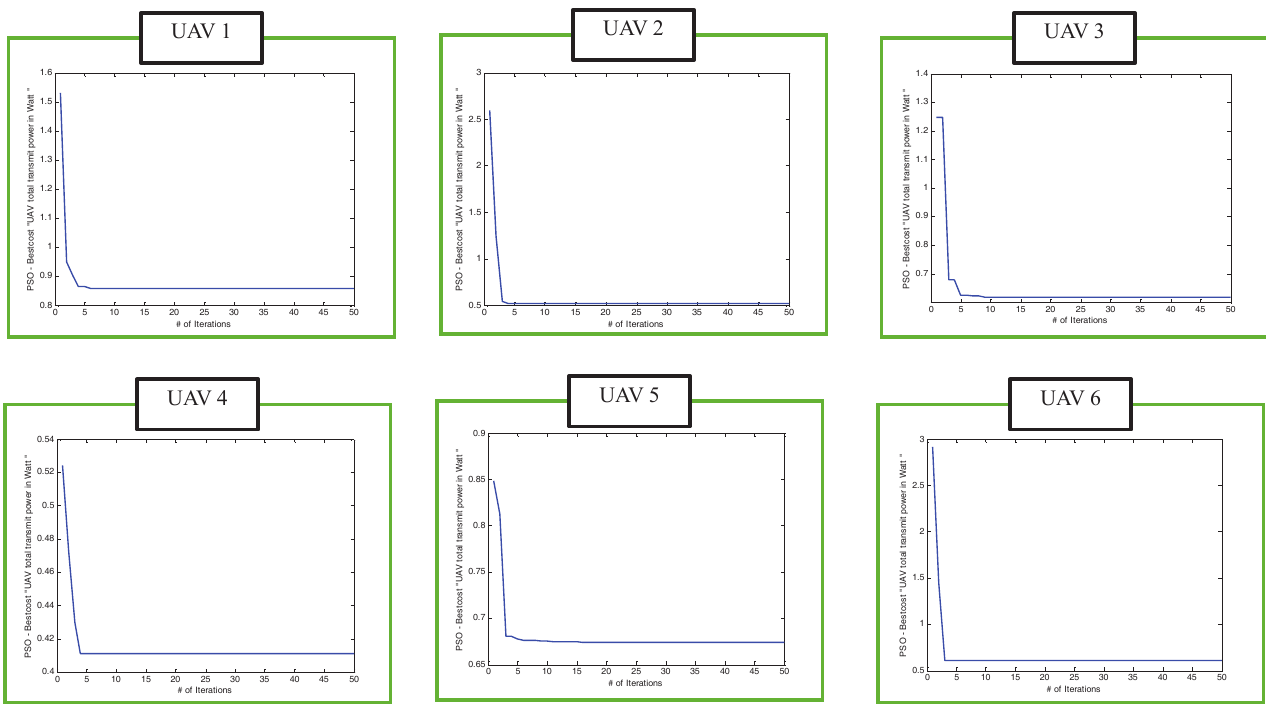
Figure 8. The convergence speeds of the power-efficient algorithm that iteratively invoked PSO-based clustering and PSO-based efficient algorithms for UAV1 to UAV6 when users were uniformly distributed. Figure 9 illustrates the optimal results of packing four, five and six equal circles inside the coverage area, S , using the CPT-based benchmarker algorithm. The problem of